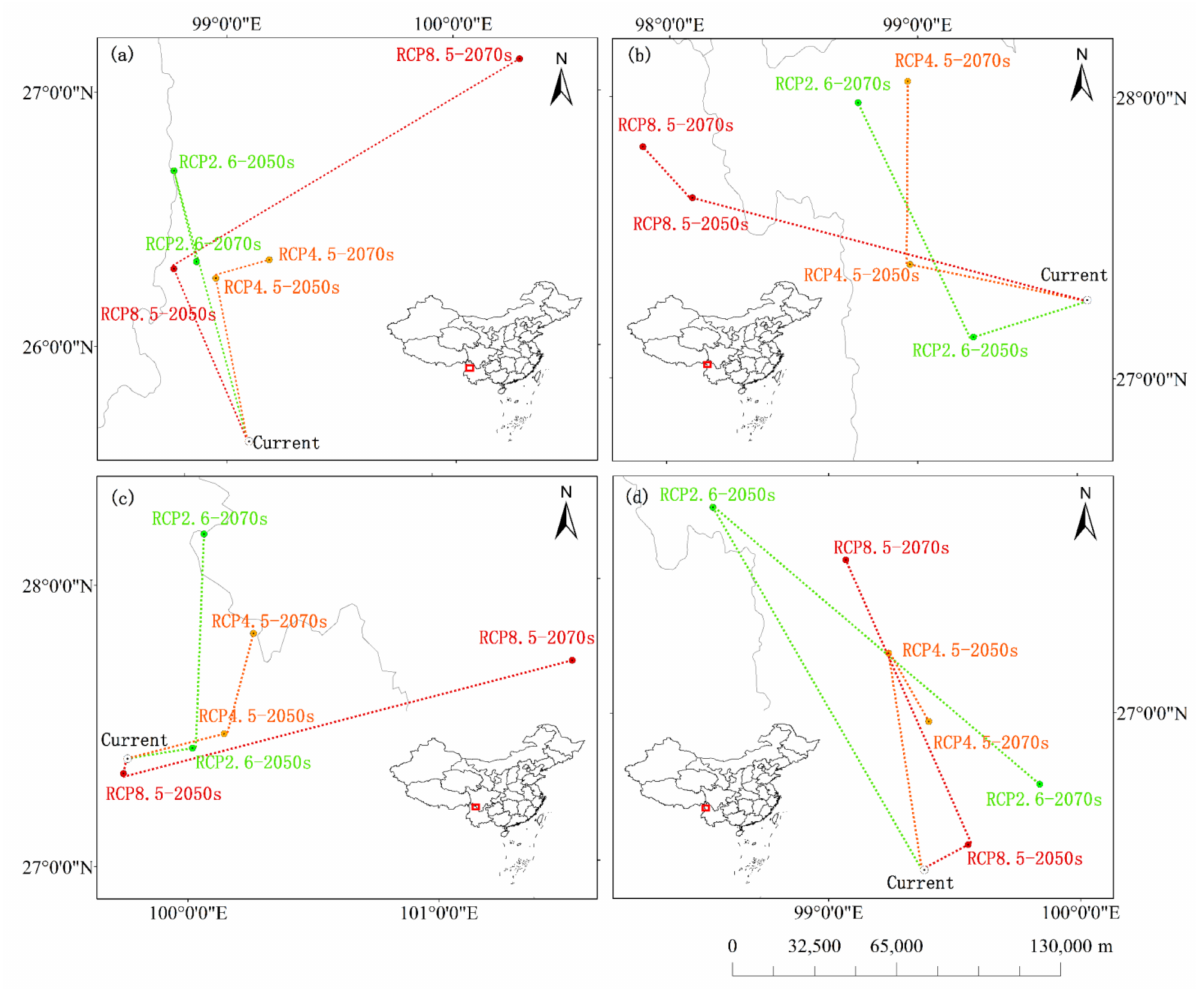
Figure 6. Map of centroid shifts of high-suitability habitats for four Rhododendron species from current–2050s and 2070s under RCP 2.6, RCP 4.5, and RCP 8.5. The green line depicts the shifting path of high-suitability habitats under RCP 2.6. The orange line depicts the shifting path of high-suitability habitats under RCP 4.5. The red line depicts the shifting path of high-suitability habitats under RCP 8.5. ( a ) R. protistum , ( b ) R. rex subsp. rex , ( c ) R. praestans , ( d ) R. sinogrande